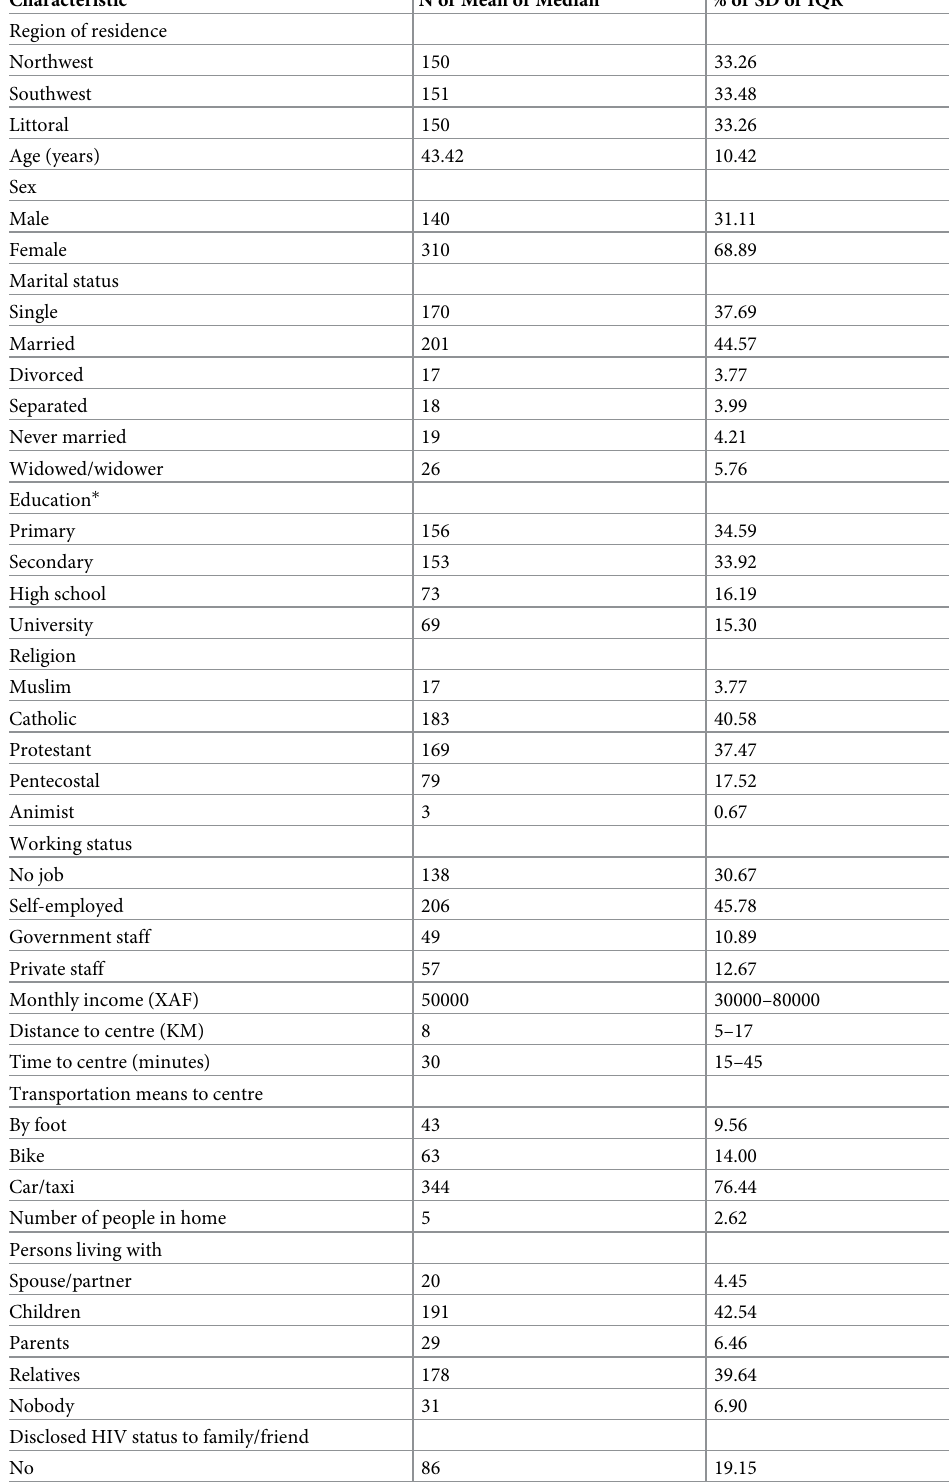
Table 1. Characteristics of the overall study population (N (%) or Mean (SD) or Median